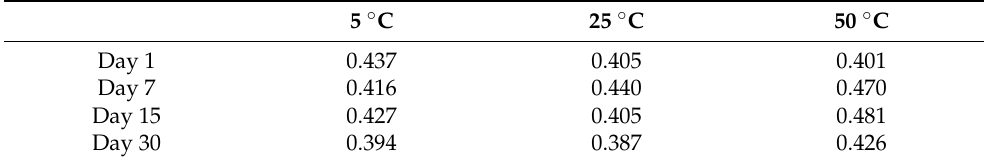
Table 2. Volume mean droplet diameter ( µ m) changes of emulsions prepared using 1% ( w/w ) OOC 80% extract and 5% ( w/w ) soybean oil, by high-pressure